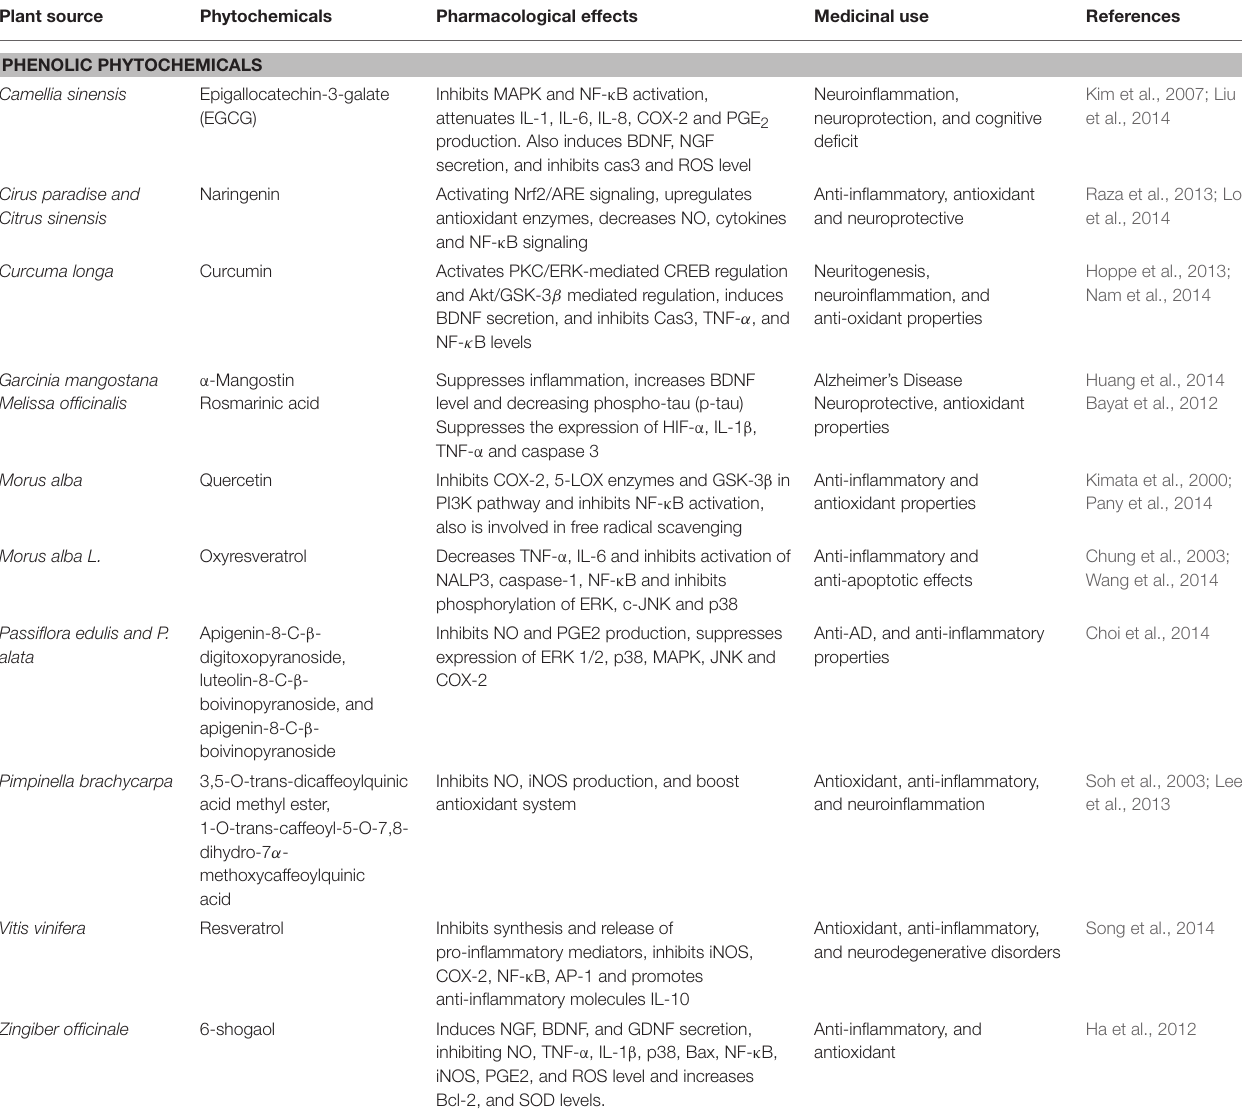
TABLE 2 | Phenolic phytochemicals that affect Alzheimer’s